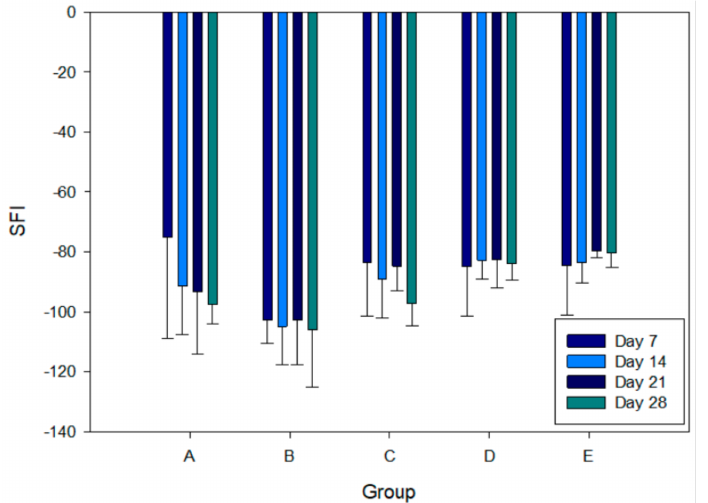
Figure 6. Sciatic function index determined from walking track analysis over 28 days for Groups